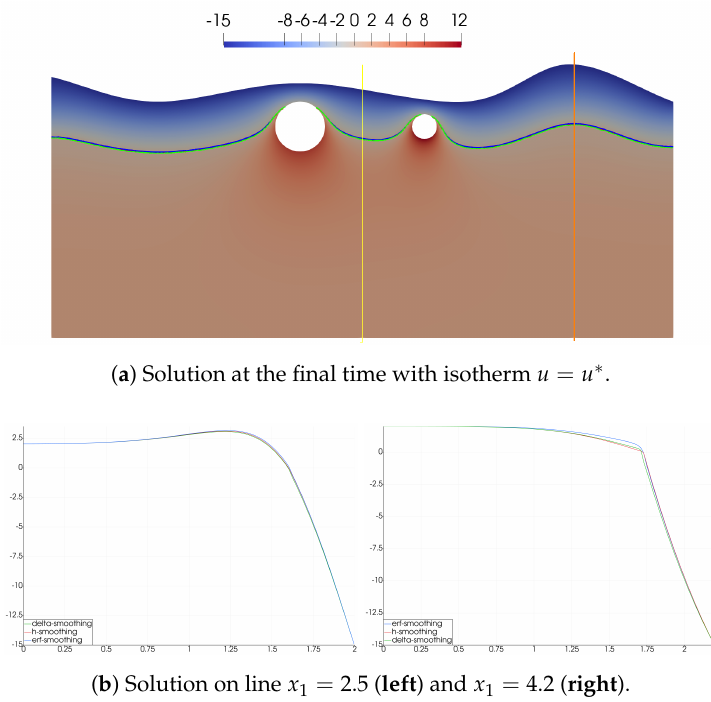
Figure 8. Geometry with the unstructured grid for g = − 15. Numerical solutions using error function smoothing (blue color), smoothing in one spatial interval (red color), and linear smoothing using the ∆ interval (green color). Yellow line: x 1 = 2.5. Orange line: x 1 =